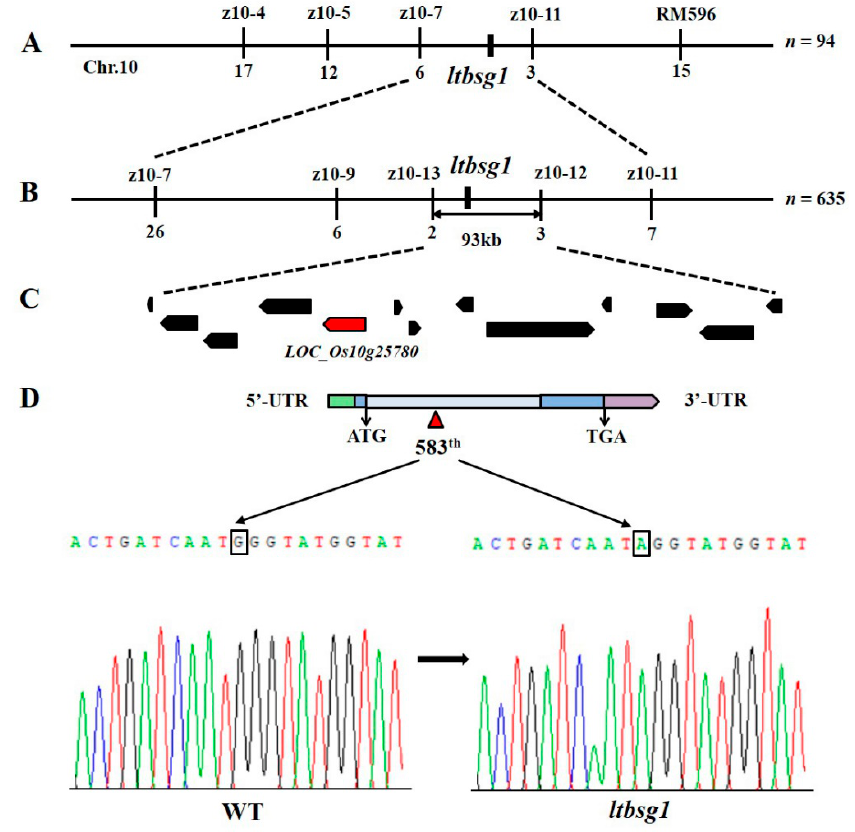
Figure 3. Map-based cloning and confirmation of the gene ltbsg1 . ( A ) Primary mapping of ltbsg1 ; ( B ) The fine mapping of gene ltbsg1 ; ( C ) The candidate genes in the target region; ( D ) The gene structure and the mutation site confirmed by sequencing analysis of LOC_Os10g25780 in WT and mutant ltbsg1 . The black box indicated the single nucleotide mutation G (WT) to A ( ltbsg1 ) at the 583th base in the exon 2. UTR: Untranslated Regions; Chr.: Chromosome.